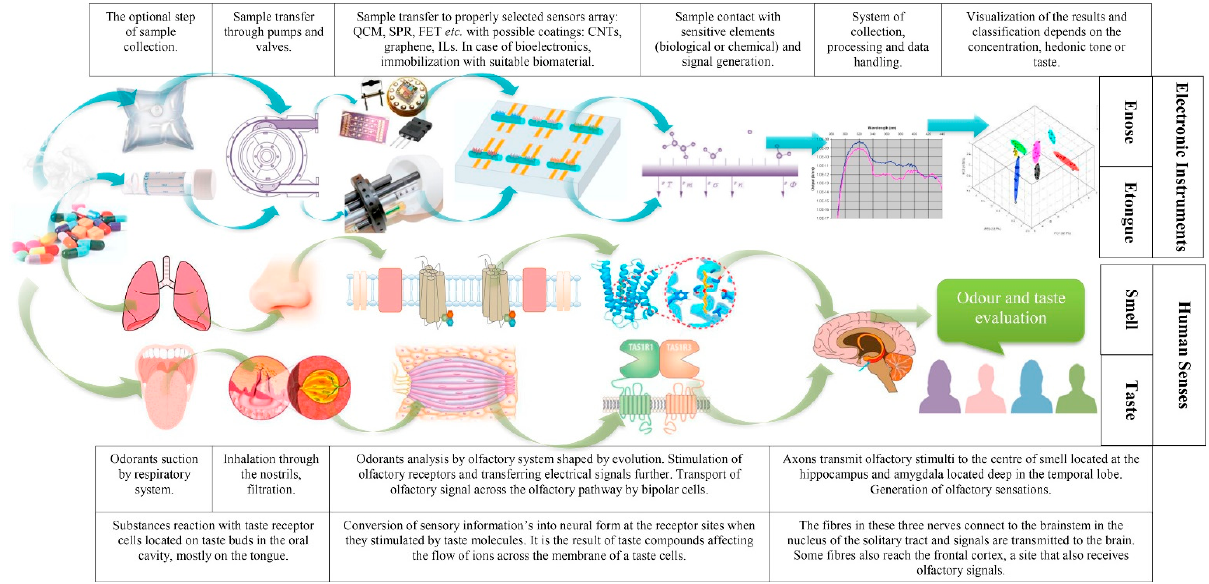
Figure 6. Comparison of operation principle of Enose and Etongue, and the analogy to the biological systems. Reproduced with permission from [27] without modification. Copyright 2019 Elsevier.